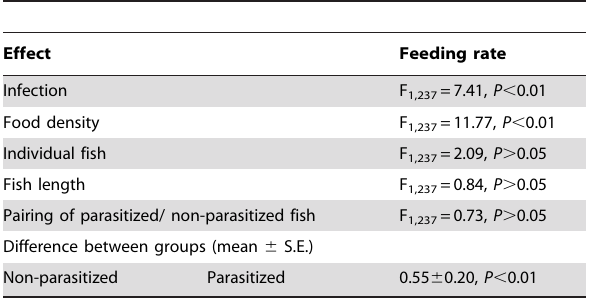
Table 4. Infection effects of Bothriocephalus acheilognathi on the feeding rate (items s 2 1 ) of Cyprinus carpio .